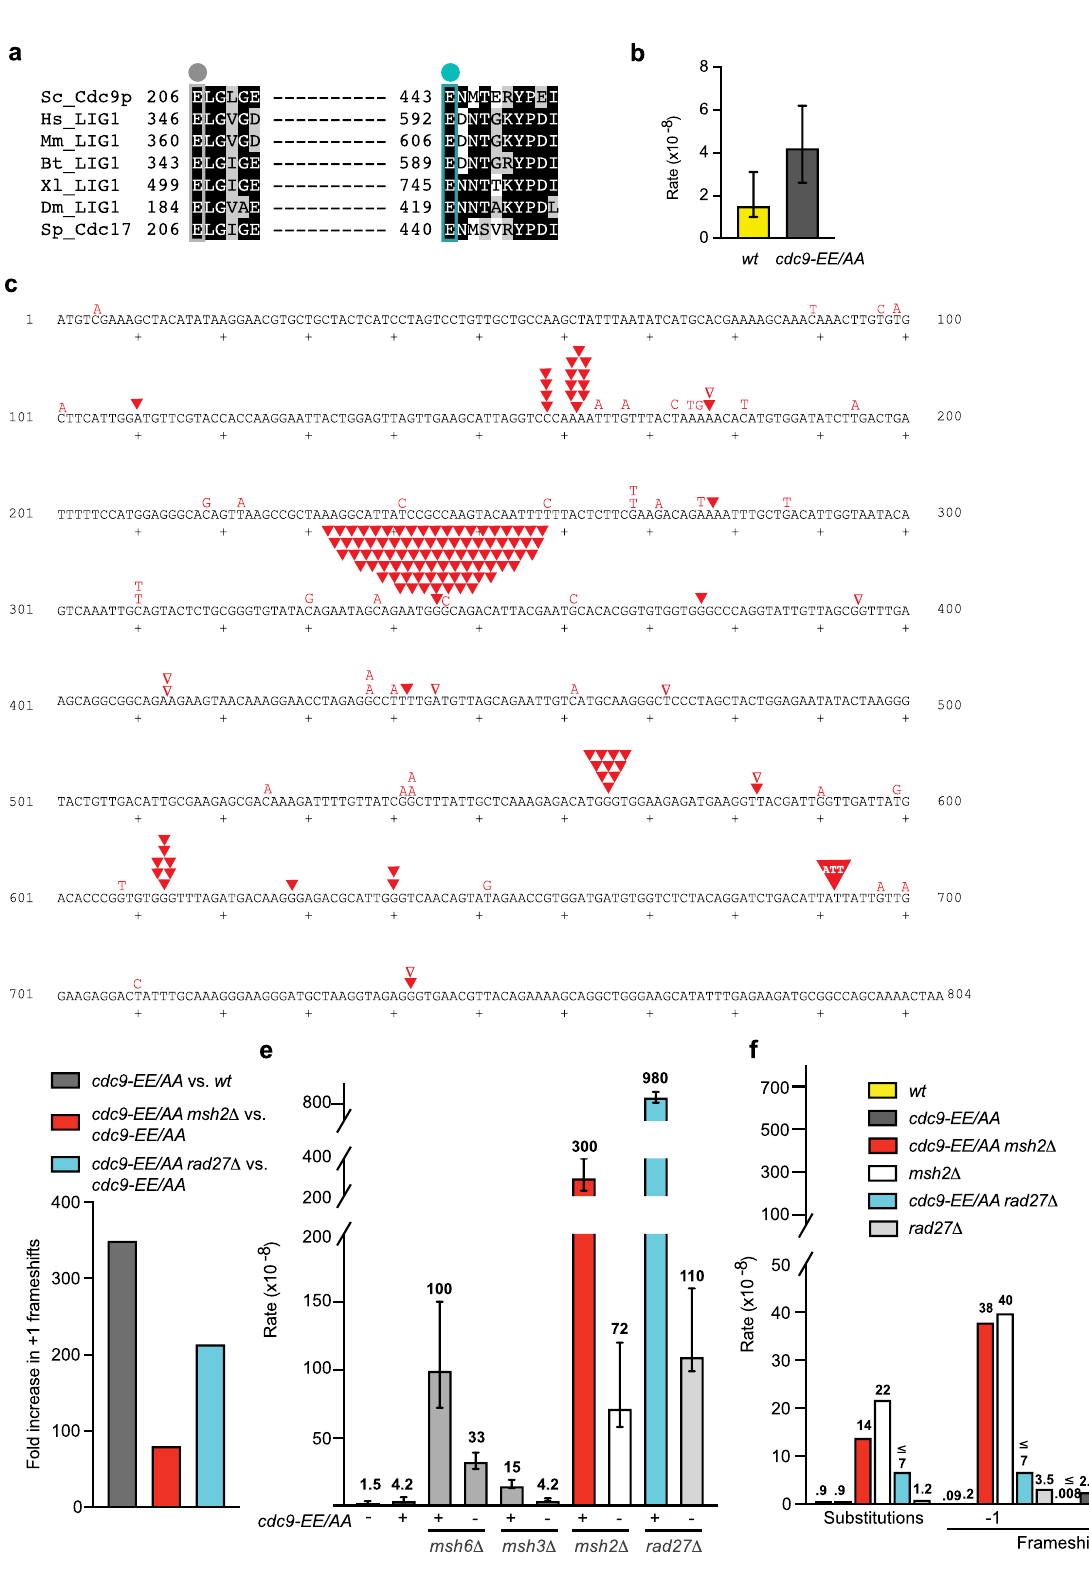
haploid has a reduced spore colony size, a defect in cell growth, and enlarged cell morphology (Supplementary Fig. 1), again suggesting a modest growth disadvantage. The cdc9-EE/AA rad27 Δ mutant also has a stronger overall mutator effect